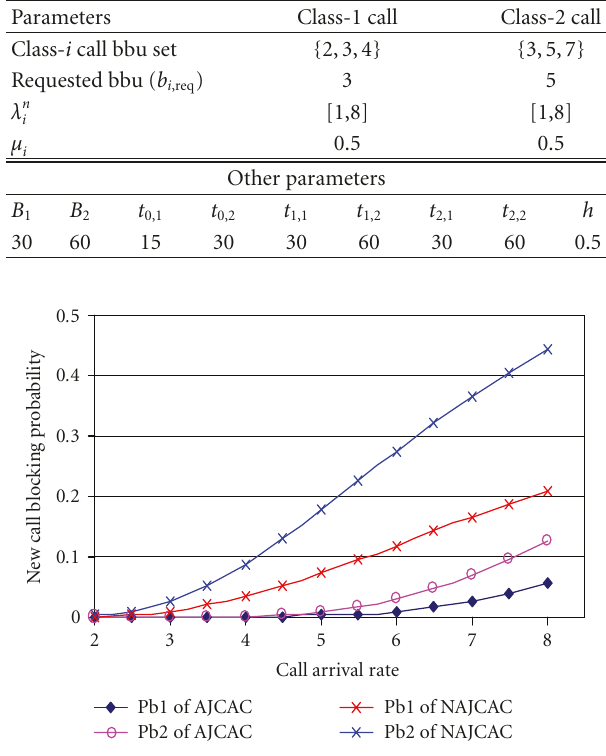
Figure 5: E ff ect of varying the call arrival rate on the new call block- ing probability.